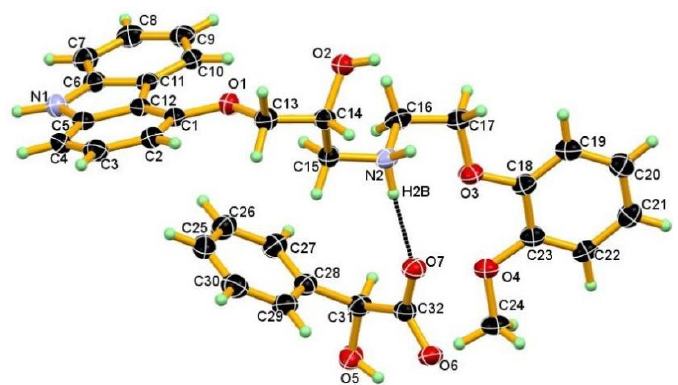
Figure 2. ORTEP diagram of CVD and DL-MA in salt showing the atom numbering scheme. Thermal ellipsoid drawing of CVD and DL-MA in salt drawn at 50% probability level, and H-atoms are shown as small spheres with arbitrary radii. Table 1. Crystallographic data table for the CVD_DL-MA salt.